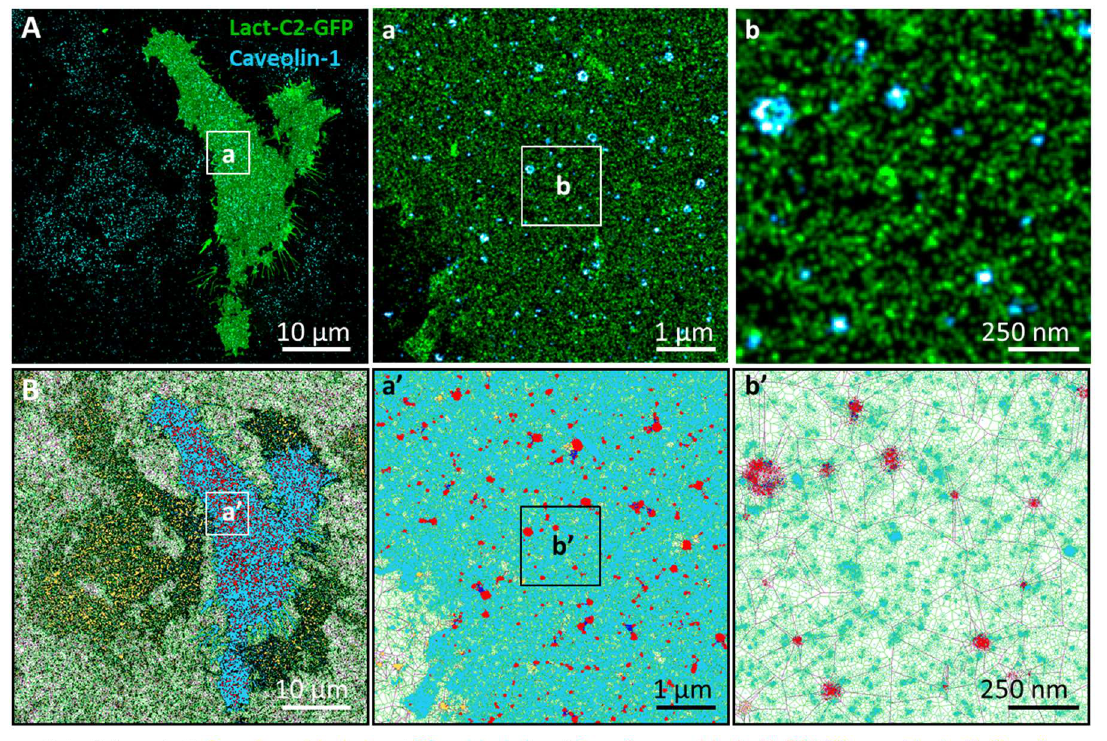
sity of the PS channel normalized to area plotted against both the Manders A (circles) and B (squares) colocalization coefficients of eight KRas-G12D U2OS cells with PS (each symbol represents one cell in the plot). ( B ) The scatterplot shows the whole cell intensity of the KRas channel normal- ized and plotted in the same way. Both plots show no relationship between intensity levels of either PS or KRas, and colocalization coefficients describing their co-organization, which rules out that increased co-organization is simply due to higher levels of probes.